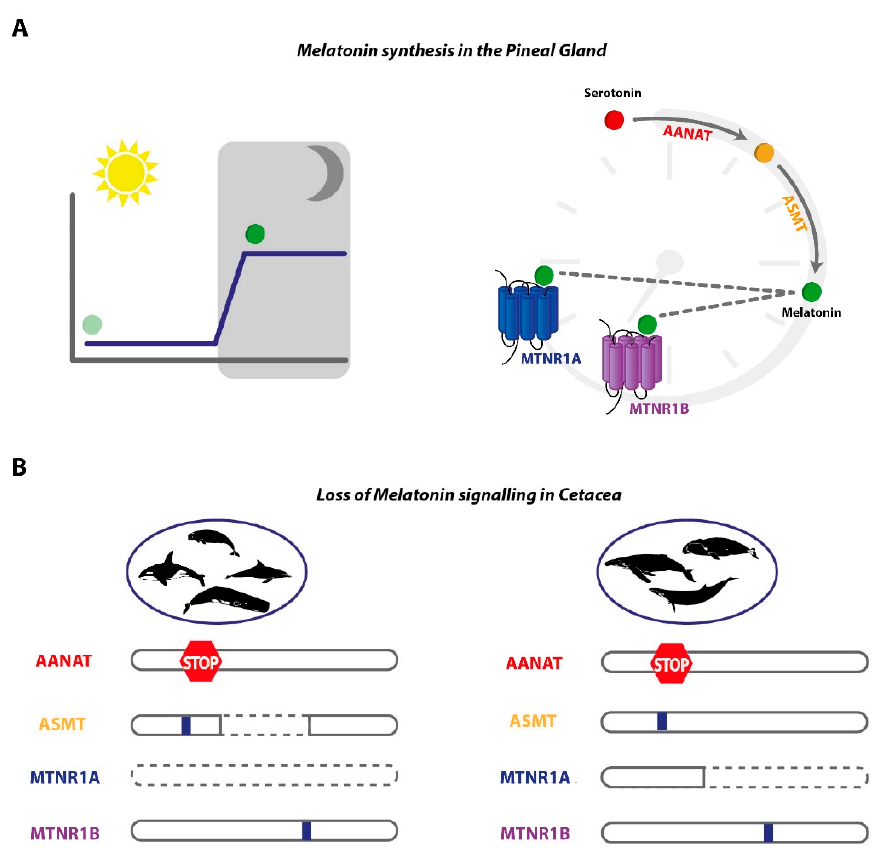
Figure 6. Melatonin synthesis and signalling modules are eroded in Cetacea. (A) Melatonin synthesis exhibits daily rhythmicity with a production peak at night (left); AANAT and ASMT sequentially convert serotonin into melatonin, which serves as ligand to two high affinity G-protein couple receptors, MTNR1A and MTNR1B (right). ( B ) Analysed genes from toothed whales (Odontoceti, left) and baleen whales (Mysticeti, right), premature stops, alternative splicing, indels (blue box), and complete gene erosion (dashed line), are depicted.